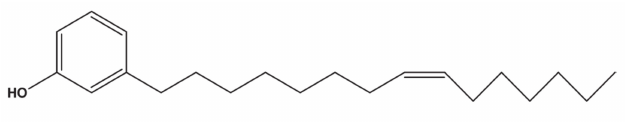
Figure 4. Structure of